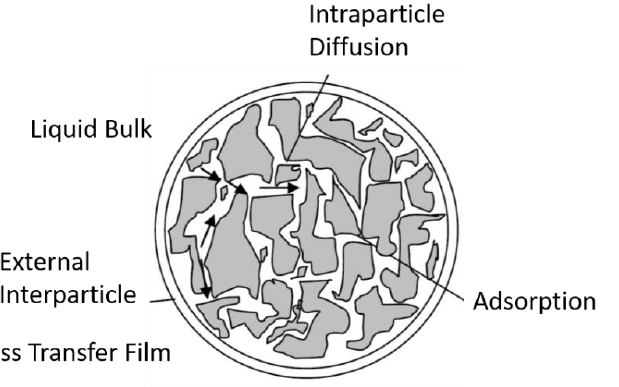
Figure 4. Steps involved in the overall adsorption process (adapted from: Muftah H. El-Naas [16]). During a continuous adsorption process in a fixed bed, the bed can be divided into three distinguished zones in (i) the saturated zone, (ii) the adsorption zone, and (iii) a clean zone in which the adsorbent contains little or no adsorbed pollutant (Figure 5). The size and location of these three zones within the bed change with time. When the concentration of pollutant on the bottom part of the filtration column reaches some critical level of satu- ration, concentrations of pollutants in an effluent are higher than the required value. This point is called the breakthrough point and the corresponding curve of pollutant concentra- tion in the effluent versus time is called the breakthrough curve . In this phase, the filtration process is stopped and the adsorption medium is cleaned. Otherwise, the concentration of pollutant in effluent rapidly increases until it reaches an exhaustion point when the column approaches saturation, and the effluent releasing the bed has the same concentra- tion of pollutant as the influent stream.